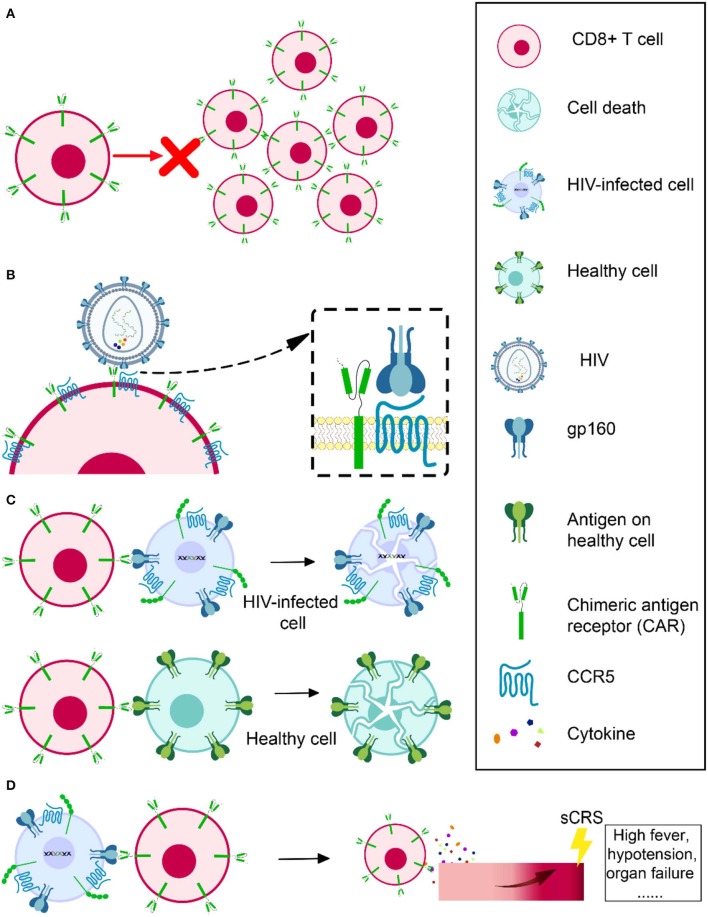
Obstacles in HIV-specific CAR T therapy development. Cell expansion and persistence in vivo
(A), susceptibility to HIV infection (B), off-target effects (C), and severe cytokine release syndrome (D).